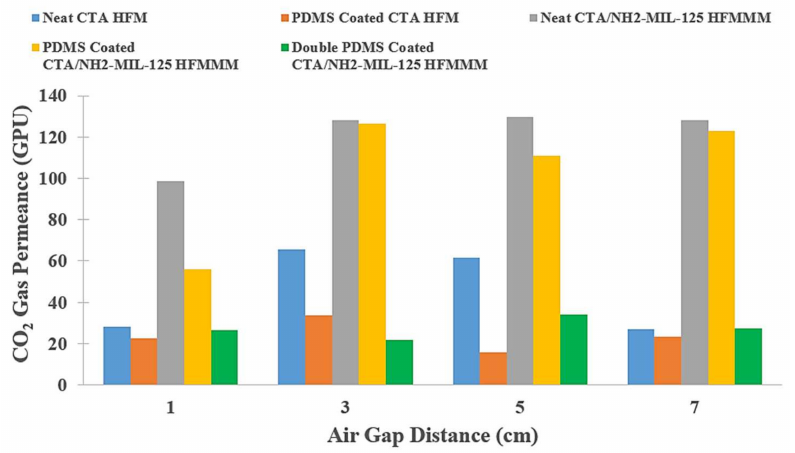
Figure 6. CO 2 gas permeance for the fabricated fibers at various air gap distances.